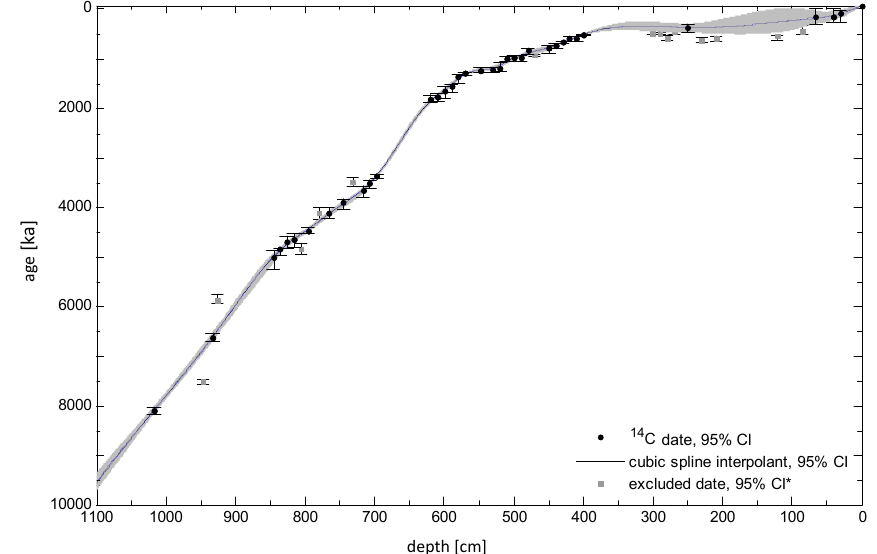
Figure 2. Age-versus-depth model for core Pe852 retrieved from Cerro Llamoca peatland based on 35 14 C dates. The grey band represents the modelled range of dates and the black line the 50th percentile of all